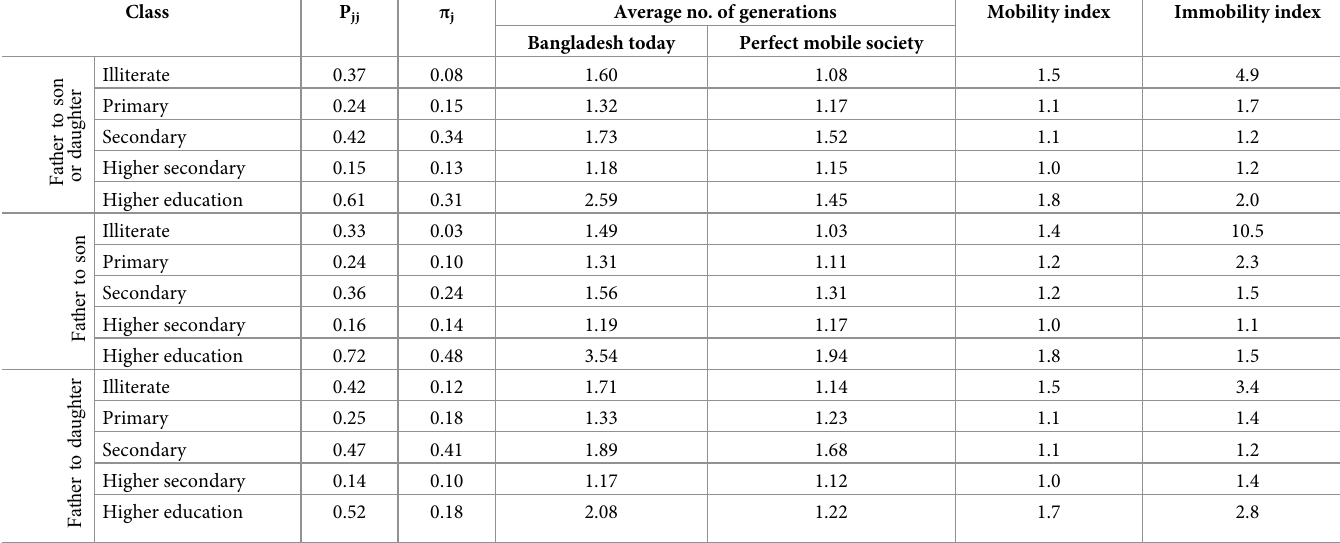
areas (with a probability of 0.41). Furthermore, the probability of a higher educated father will have a higher educated child is higher in urban areas than in rural areas of Bangladesh. The analysis of the average number of generations spent in each education class with mobility and immobility indices are presented in Table 4. The average time spent in each class (Bangla- desh today) reveals that none of the education classes except higher education exceeds two gener- ations. The longer time spent is observed for higher education with 3.54 generations for sons and 2.08 generations for daughters. Moreover, the average number of generations that would be spent in each class if the society were perfectly mobile shows that least time (1.08 generations) Table 4. The average number of generations spent in each social class, mobility and immobility indices in Bangladesh. Class P jj π j Average no. of generations Mobility index Immobility index Bangladesh